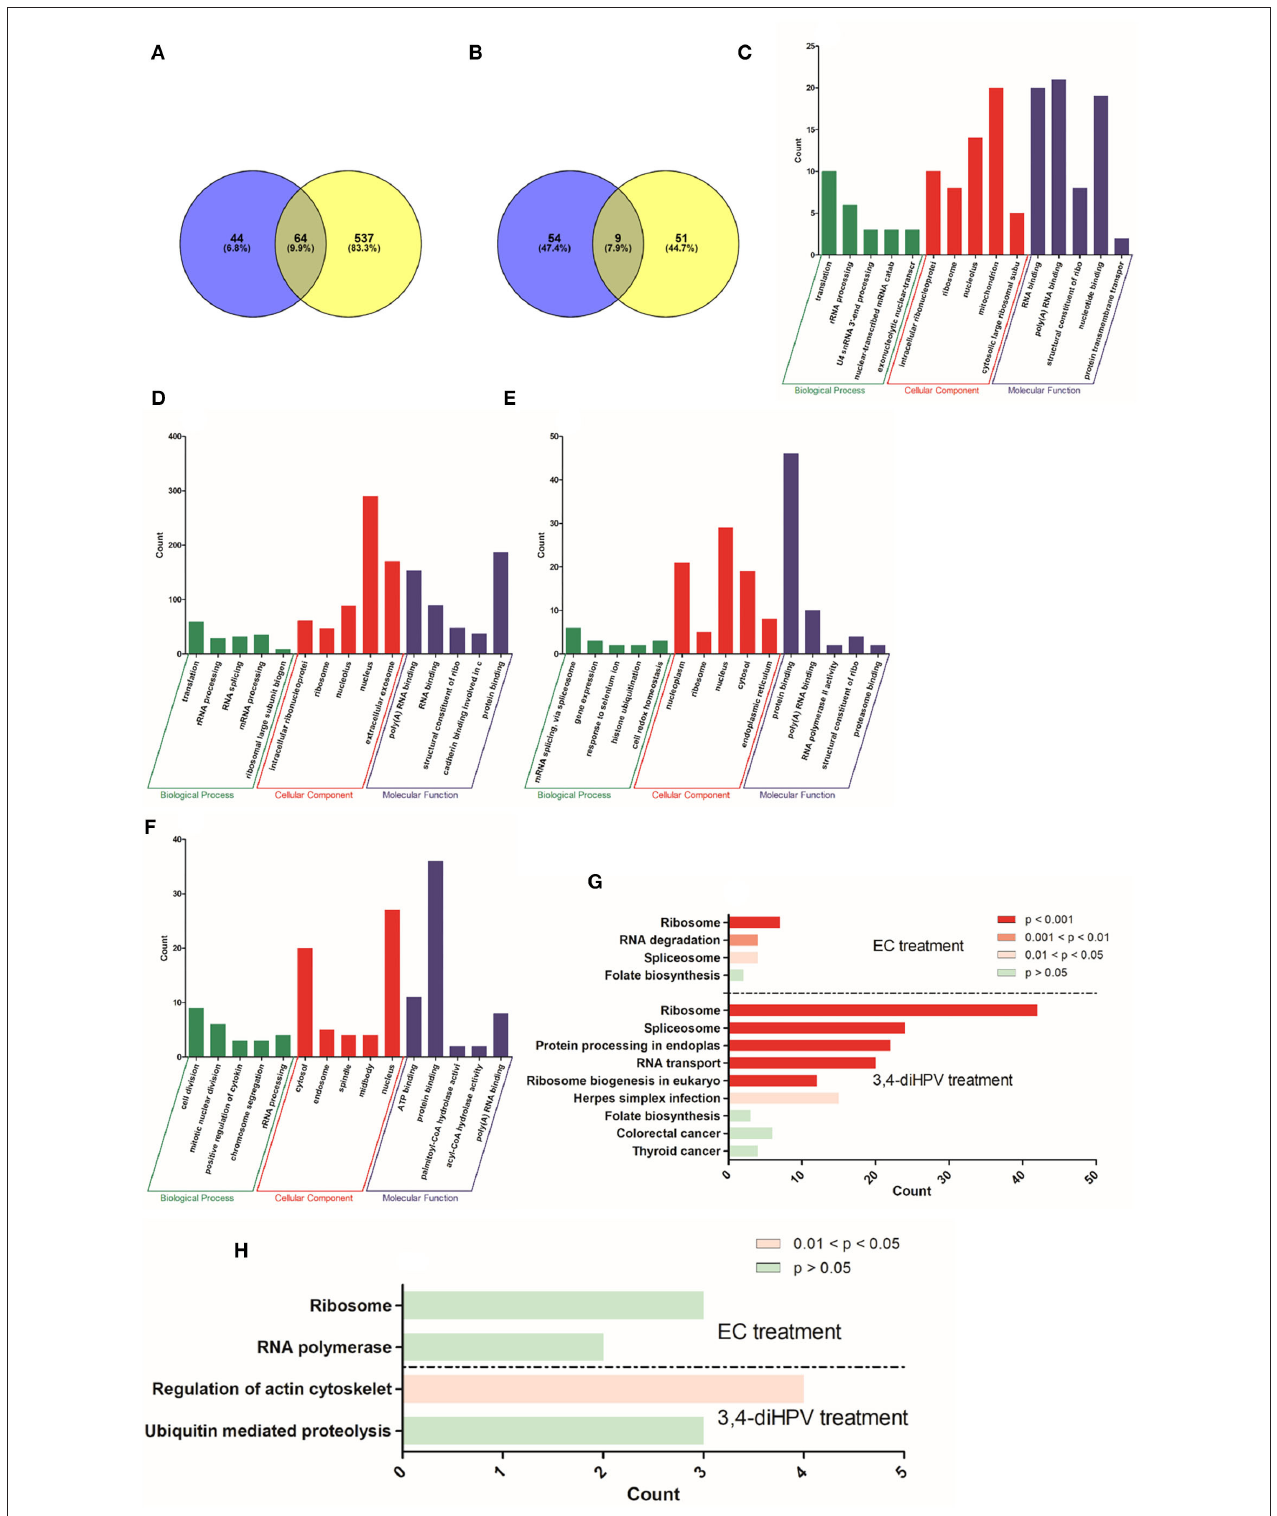
FIGURE 5 | Numbers of DEPs identified by label-free proteomics upon treatment of Hepa1c1c7 cells (A) and Caco-2 cells (B) with either 30 µ M EC (blue circle) or 30 µ M 3,4-diHPV (yellow circle). GO enrichment of DEPs from 30 µ M EC (C) and 30 µ M 3,4-diHPV (D) treated Hep1c1c7 cells and from 30 µ M EC (E) and 30 µ M 3,4-diHPV (F) treated Caco-2 cells. The y-axis value reflects the number of proteins differentially regulated in respective GO terms. KEGG pathway enrichment analysis of DEPs from Hepa1c1c7 cells (G) and Caco-2 cells (H) treated with 30 µ M of either EC or 3,4-diHPV.